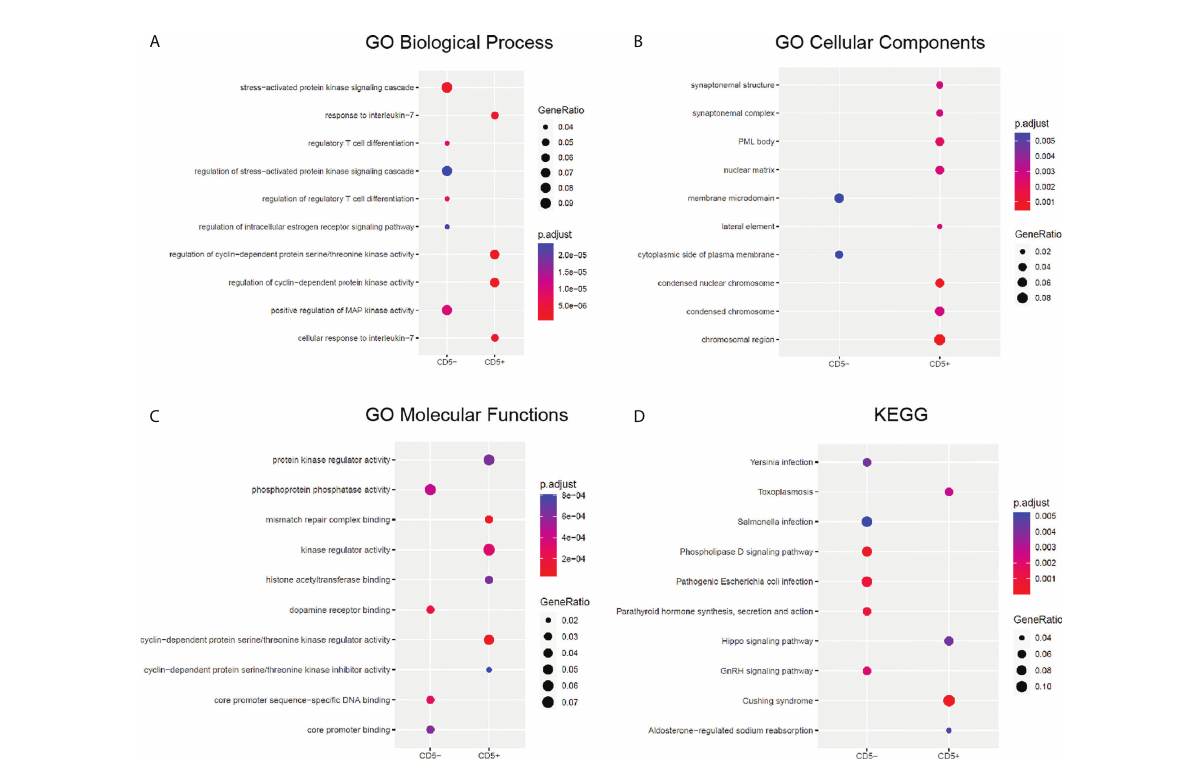
FIGURE 3 GO and KEGG analyses of CD5+ and CD5- DLBCL. The distinct GO enrichments of altered genes in CD5+ and CD5- DLBCL were ranked by signi fi cance in terms of (A) biological processes, (B) cellular components, and (C) molecular functions. (D) The distinct KEGG enrichments of altered genes in CD5+ and CD5- DLBCL were ranked by statistical signi fi cance. GO, gene ontology; KEGG, Kyoto Encyclopedia of Genes and